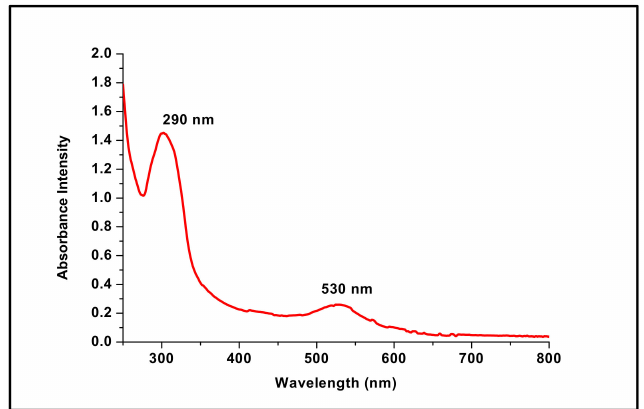
Figure 2. UV-Visible spectroscopy of DFX-AuNPs showing SPR band at 530